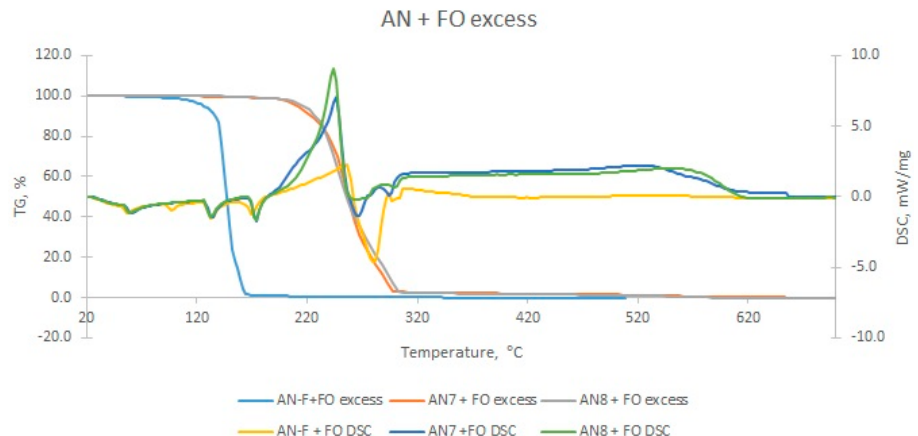
Figure 9. TG / DSC results of AN with fuel oil (FO) Figure 9. TG/DSC results of AN with fuel oil (FO) excess.